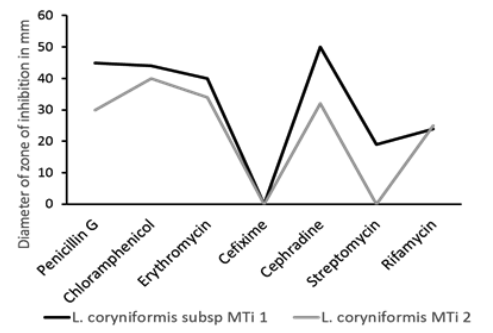
Fig. 3. Resistance pattern of L. coryniformis subsp torquens MTi1 and L. coryniformis MTi2 against some commonly used antibiotics